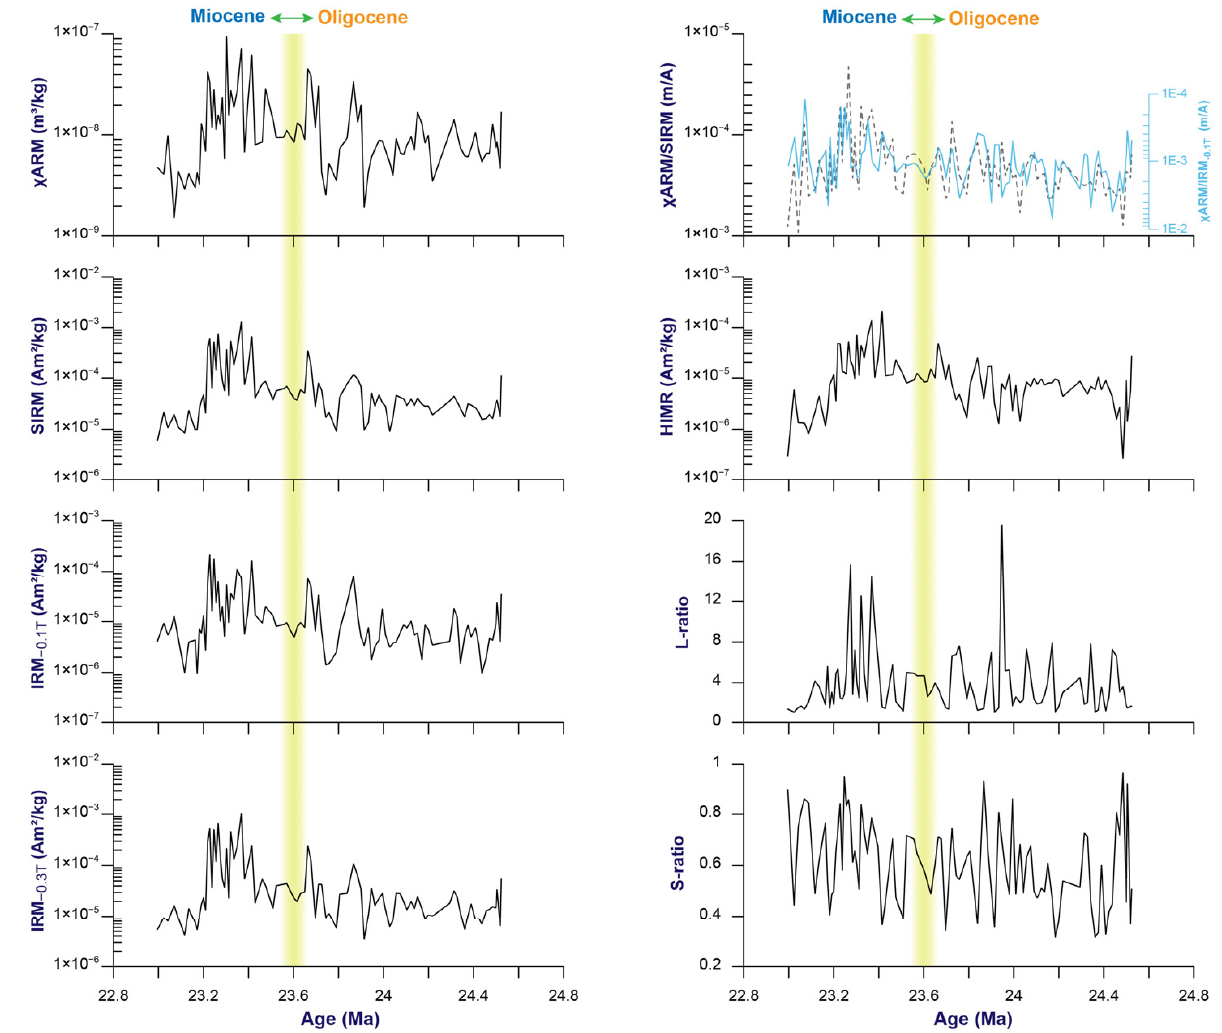
Figure 3. Changes in the magnetic parameters of core XK-1.